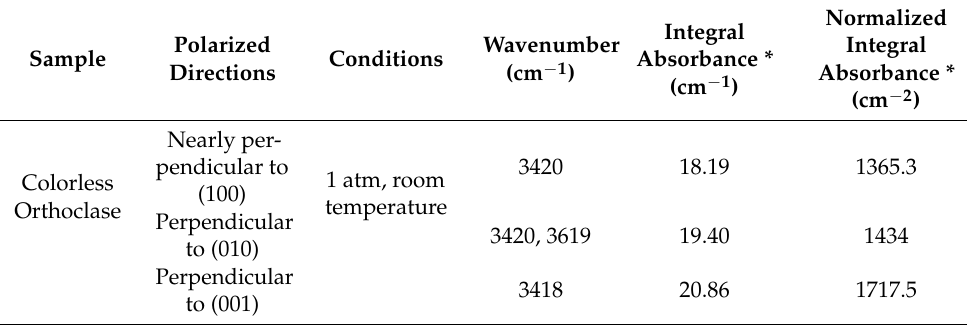
Figure 4. FTIR spectra of colorless orthoclase with the polarization direction of the IR radiation oriented perpendicular to (001), (010), and (100) vibration directions. The spectra are stacked for comparison. Table 4. FTIR spectra and analysis of colorless orthoclase at 1 atm pressure.